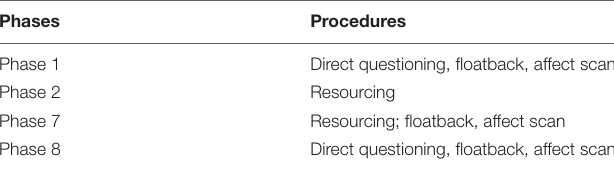
TABLE 2 | Procedures in EMDR therapy related to the eight